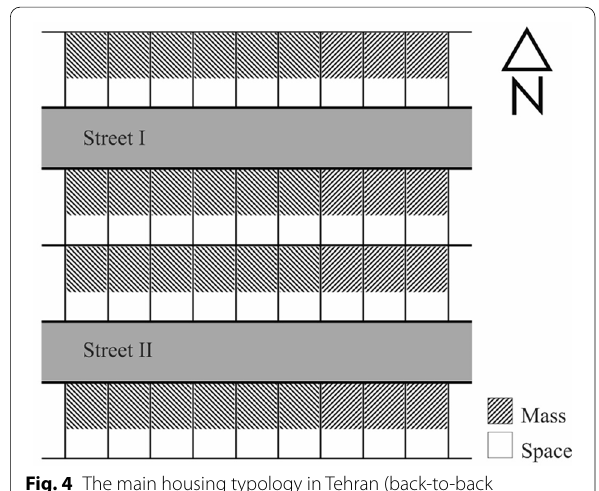
Fig. 4 The main housing typology in Tehran (back-to-back buildings—40 to 60 ratio)